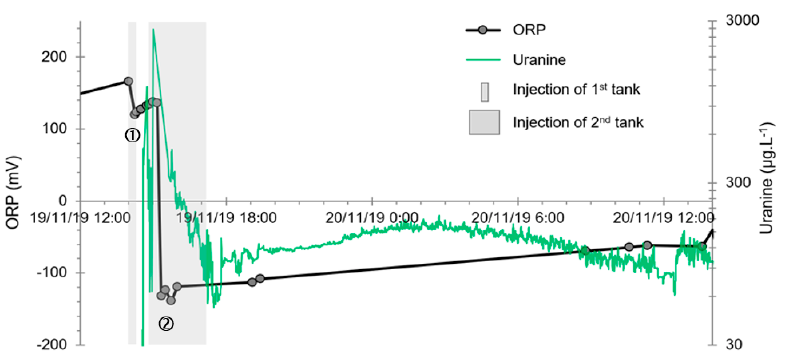
Figure 15. Detailed evolution of the oxidation-reduction potential and the tracer concentration at PZ2BIS (5 m downstream) during the day dissolved hydrogen was injected.